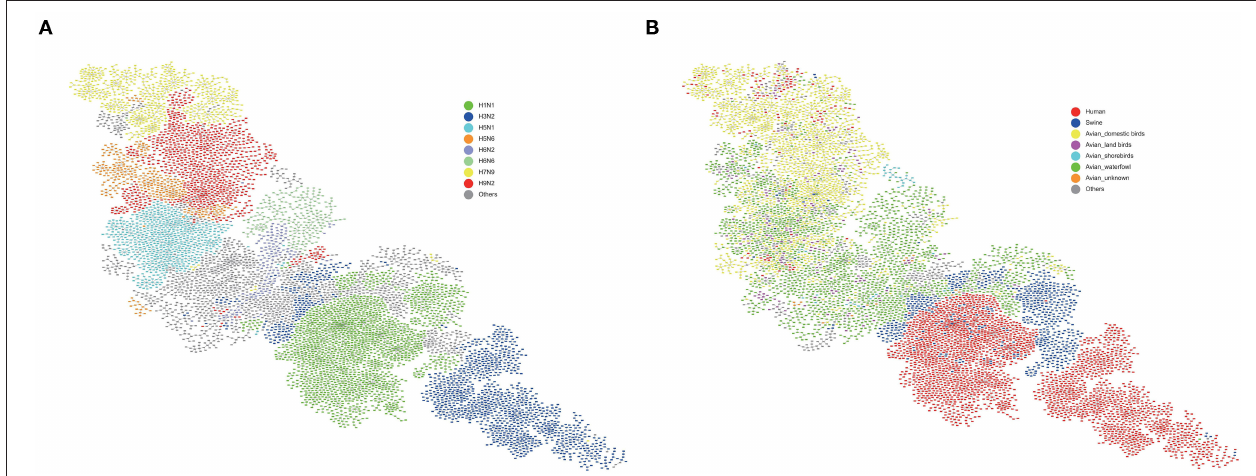
FIGURE 3 | Virus similarity network. (A) Different subtypes are represented by different colors. Viruses with the same subtype are clustered. (B) Different hosts are represented by different colors. Swine and domestic birds play an important role in human infection with avian influenza virus. The blue nodes in the middle represent swine hosts. Above these swine nodes are almost all avian host nodes (yellow-domesitic birds, purple-land birds, light blue-shorebirds, green-waterfowl), and below these swine hosts are almost all human host nodes (red). This implied that swine plays the role of an intermediate host between these avian host and human host. At the top of (B) , a small number of human host nodes can be found clustered. These nodes are close to the domestic birds node (yellow). Therefore, domestic birds also play an important role in the avian influenza viruses’ cross-species and infecting humans. Avian waterfowls were considered as the natural hosts of IAVs, domestic birds and swine may have played an important role as incubation for the IAVs’ transmission to humans.